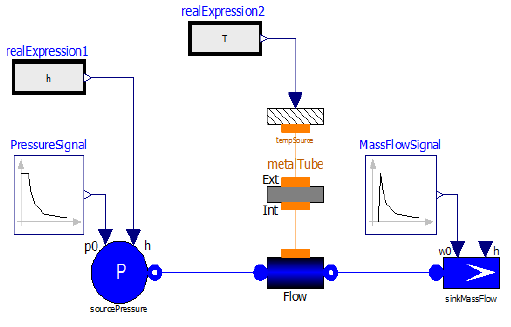
Fig. 2. Object-oriented configuration of the